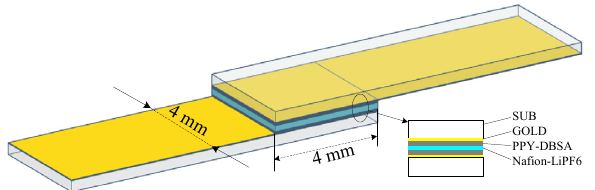
Figure 11. Schematic view of the supercapacitor structure subjected to low frequency impedance measurements. The substrate (SUB) is cut out from a copier grade transparency sheet on top of which a gold layer (GOLD) was thermally evaporated. Electrodes are obtained from polypyrrole powder dispersed in Dodecylbenzenesulfonic acid (PPY-DBSA) and are separated by a mixture of Nafion and lithium hexafluorophospate (Nafion-LiPF6).